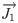
Design and installation of the metamaterial ring antennas.(A) Schematic sketch of a unit cell of the metamaterial ring antenna design. The quantity p stands for the footprint (i.e. periodicity) of one unit cell. Metal-insulator-metal (MIM) multilayer realization of the unit cell (outer, intermediate and inner metal layers are displayed in black, red and grey) where the shunt inductor LL is introduced as a lumped (or chip) element and CL as the capacity for the left-handed contribution. (B) Simulation model of the metamaterial ring antenna with the current density J1→ on the surface along the ring structure and the H field distribution. (C) Exemplary installation of one pair of mobile and versatile metamaterial ring antennas (diameter 51 cm) inside of the 7 T MRI system bore (diameter 60 cm).